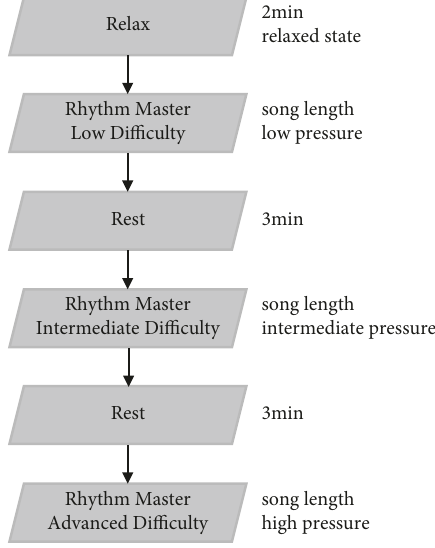
Figure 3: Experimental processes. Table 1: Frequency and noise distribution of wavelet